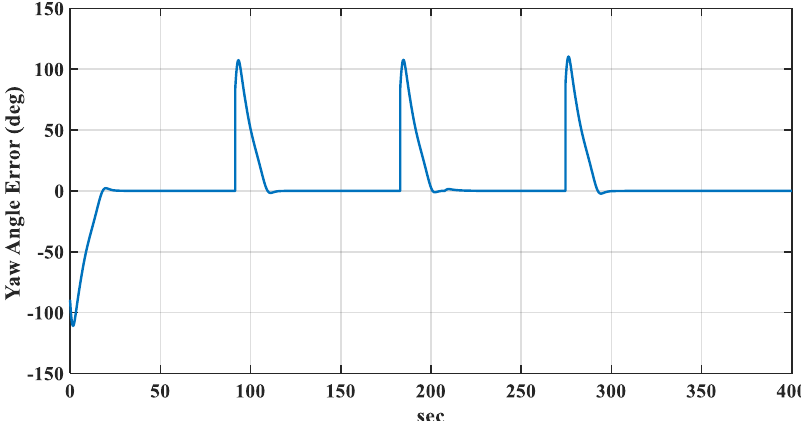
Figure 9. Yaw angle error using the non-optimized FLC.